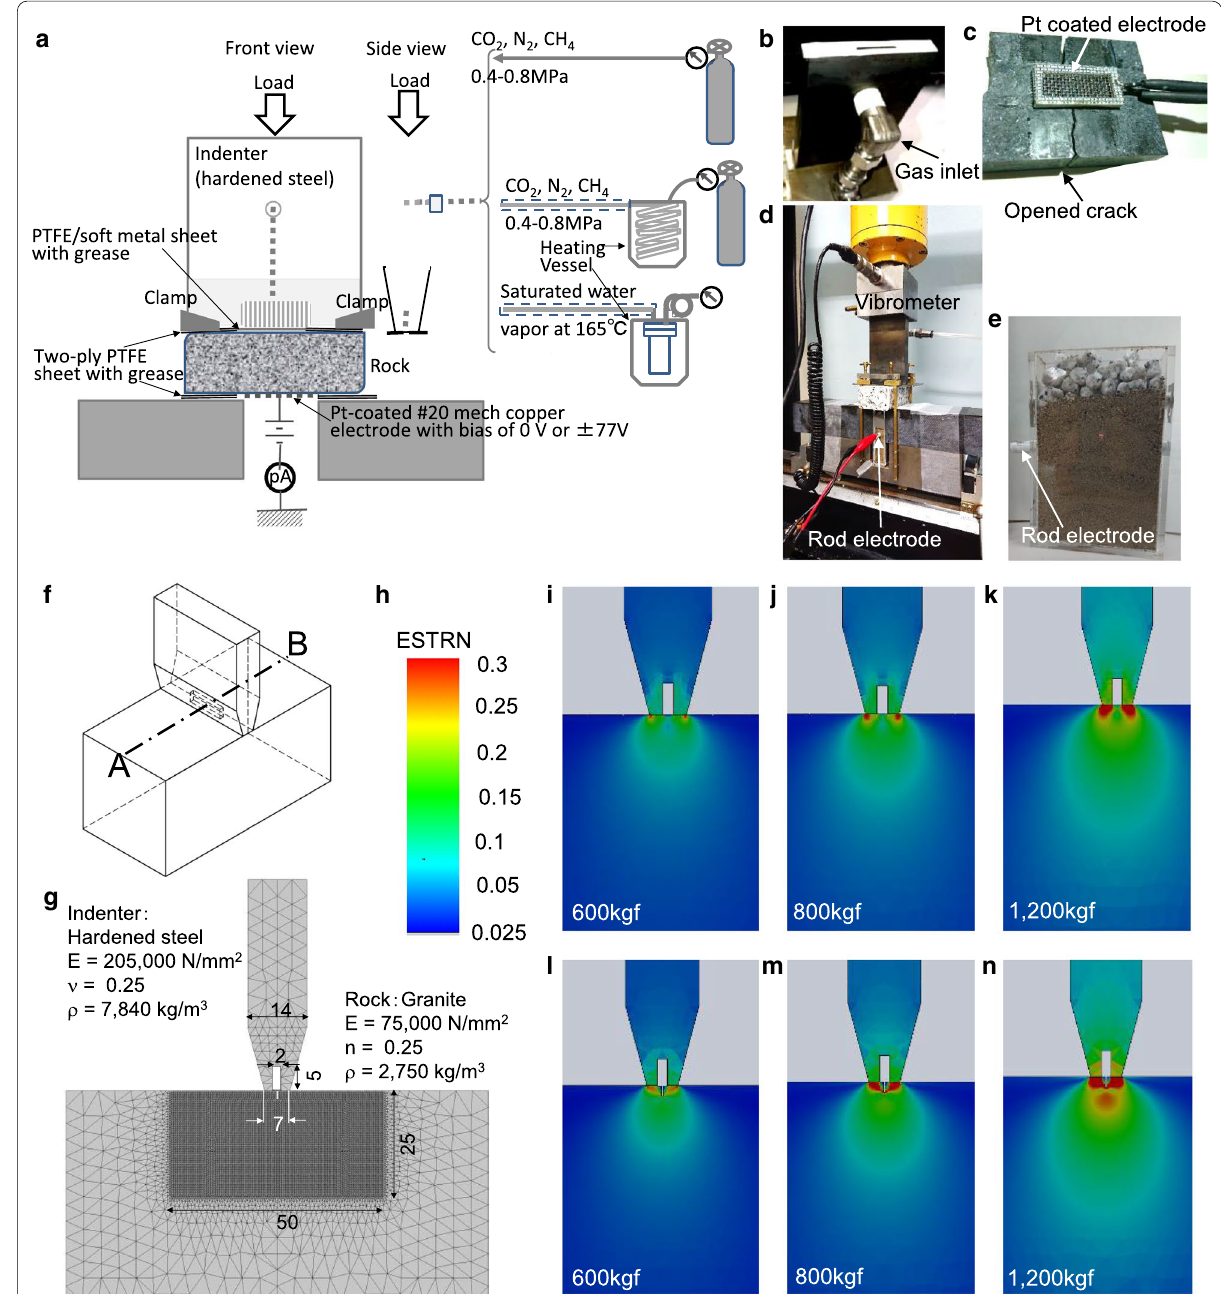
Fig. 1 a Schematic view of the experimental setup: universal tester for the measurement of electrified gas current interacting with fractured rock at temperatures of ~ 25 °C and ~ 160 °C, with the three methods of gas supply shown on the right side; b flat-ended indenter gas outlet (slit) covered with PTFE seal, as seen from below; c bottom view of Pt-coated mesh electrode attached to the underside of the rock; d setup in fourth series of experiments with an electrode (stainless-steel rod with or without resin coating) buried in acrylic container filled with granite grains and soil; e close-up of container in d ; f three-dimensional model of flat-ended indenter on a rock; g meshing for model shown in f , with contact configuration, mesh refinement near stress concentration, line A–B, and parameters; h colour coding of equivalent strain; and i – k and l – n two-dimensional strain distribution along a line A–B at loads of 600, 800, and 1200 kg without and with a small flaw on the rock surface,